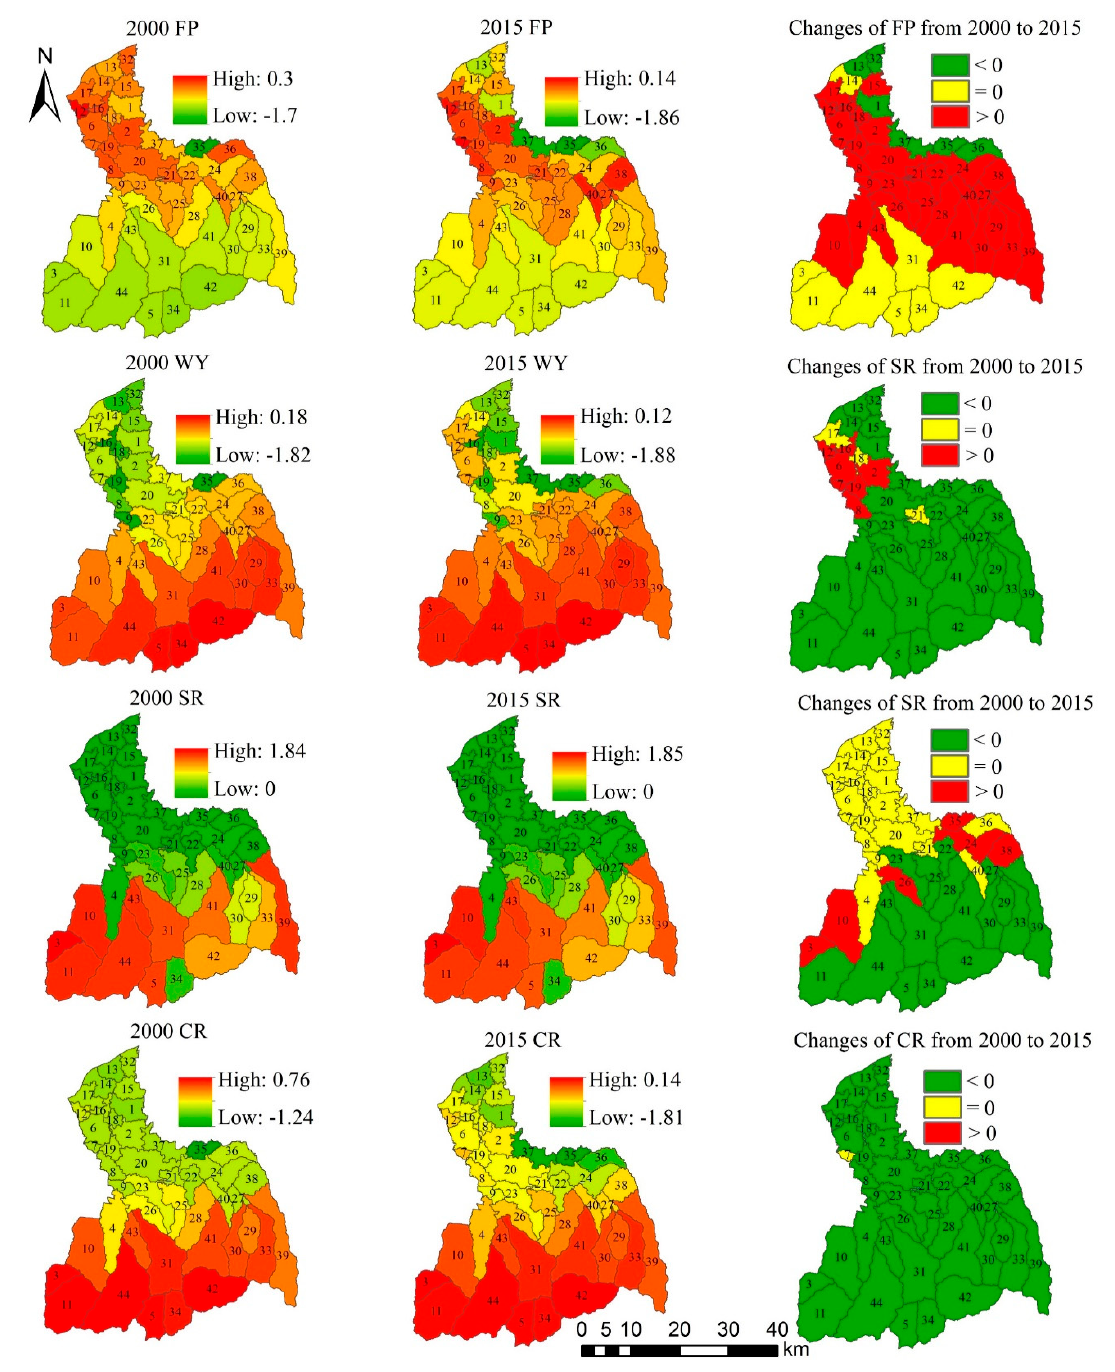
Figure 13. The spatial distribution and spatiotemporal change of the supply–demand ratio in the sub-watershed scale.